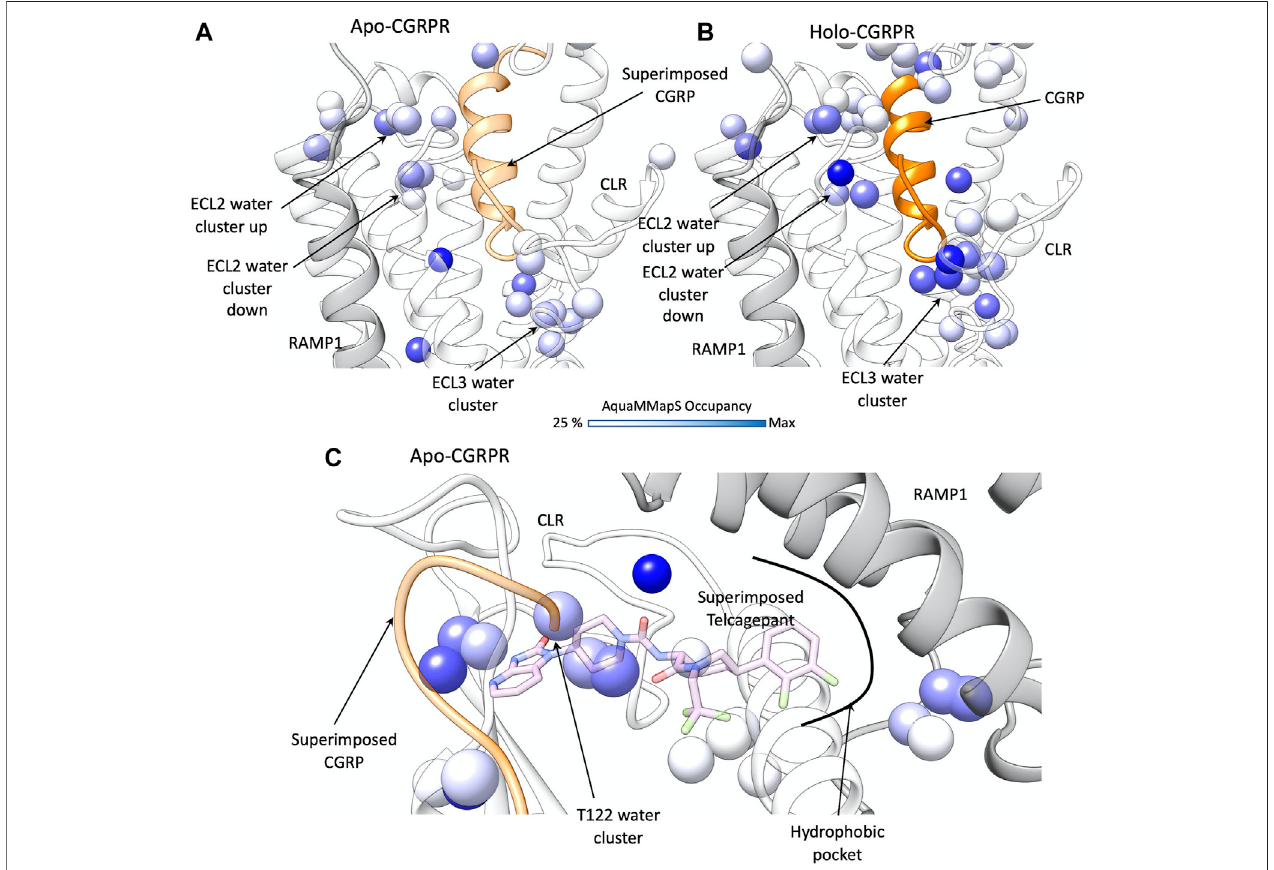
FIGURE3| WaternetworkperturbationuponCGRPandtelcagepantbinding. (A) hydrationpositionsintheTMDoftheactiveCGRPR(whiteribbon,representative conformationfromthe fi rstframeofMDsimulation),afterremovalofligand;CLRandRAMP1areshownastransparentwhiteandgreyribbons,CGRPfromPDB6E3Yis superimposed (by superimposing TMD scaffolds) and shown as a transparent orange ribbon; (B) hydration positions in the holo CGRPR TMD (representative conformation from the fi rst frame of MD simulation). CLR and RAMP1 are shown as transparent white and grey ribbons, CGRP as an orange ribbon; (C) hydration positions in the ECD of the active CGRPR, after removal of any ligand; CLR and RAMP1 are shown as transparent white and grey ribbons, CGRP from PDB 6E3Y and telcagepant from PDB 3N7R are superimposed and shown as transparent orange ribbon and pink sticks, respectively. In (A – C ) the color scale of the hydrated spots corresponds to the occupancy of water molecules during the MD simulation (in dark blue the maximum occupancy).